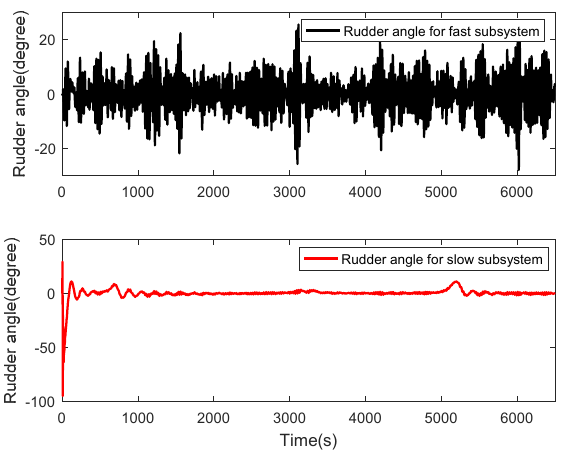
Figure 11. Rudder commands in the slow subsystem and the fast subsystem.